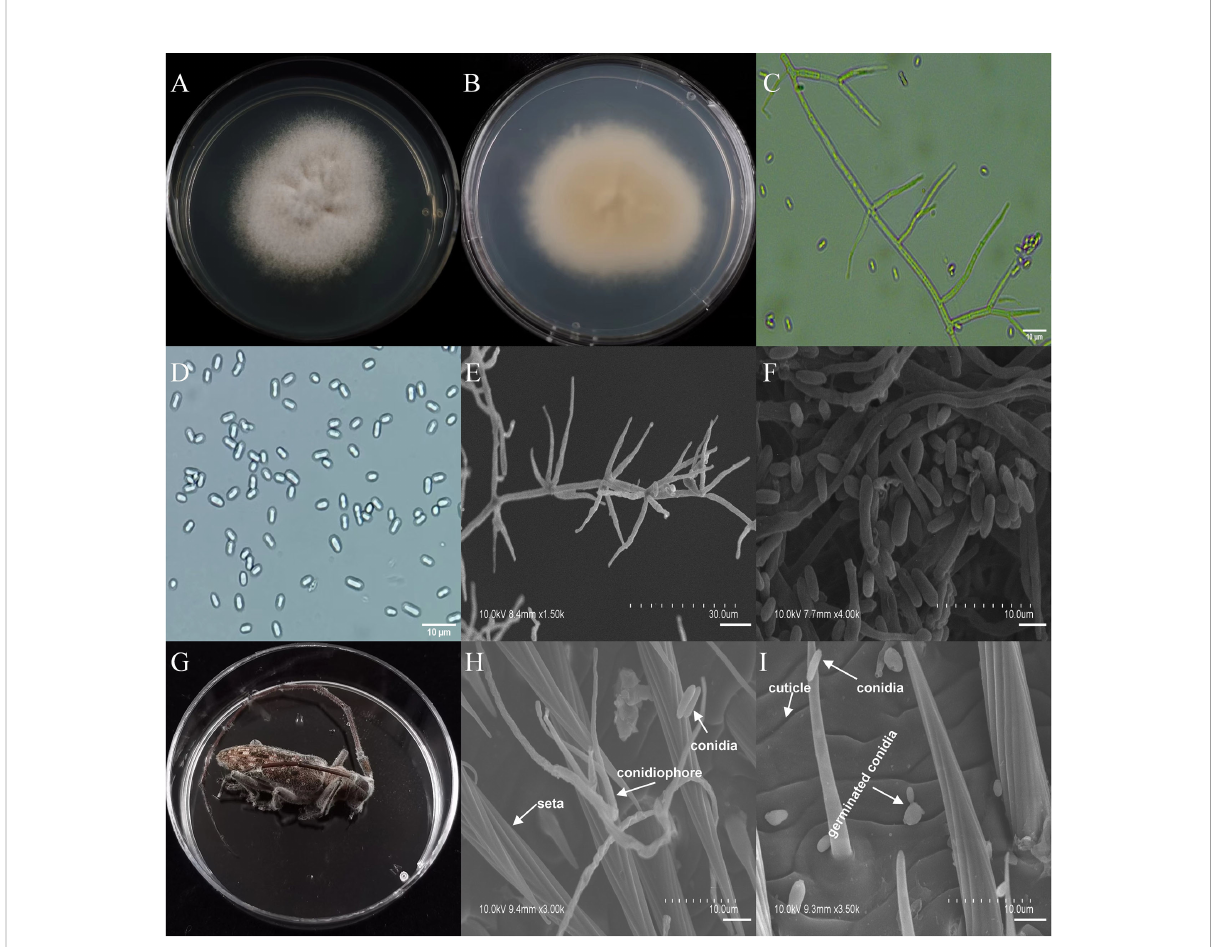
FIGURE 5 Morphology of L . attenuatum and M . alternatus cadaver infected by L . attenuatum under optical microscope and SEM. (A) Colonial morphology cultured on PDA. (B) Reverse of colony on PDA. (C) Hyphae and conidiophores (OM). (D) Conidia (OM). (E) Conidiophores (SEM). (F) Conidia (SEM). (G) M . alternatus cadaver surrounded by mycelia. (H) Conidiophores grown from M . alternatus cuticle (SEM). (I) Conidia on M . alternatus cuticle surface